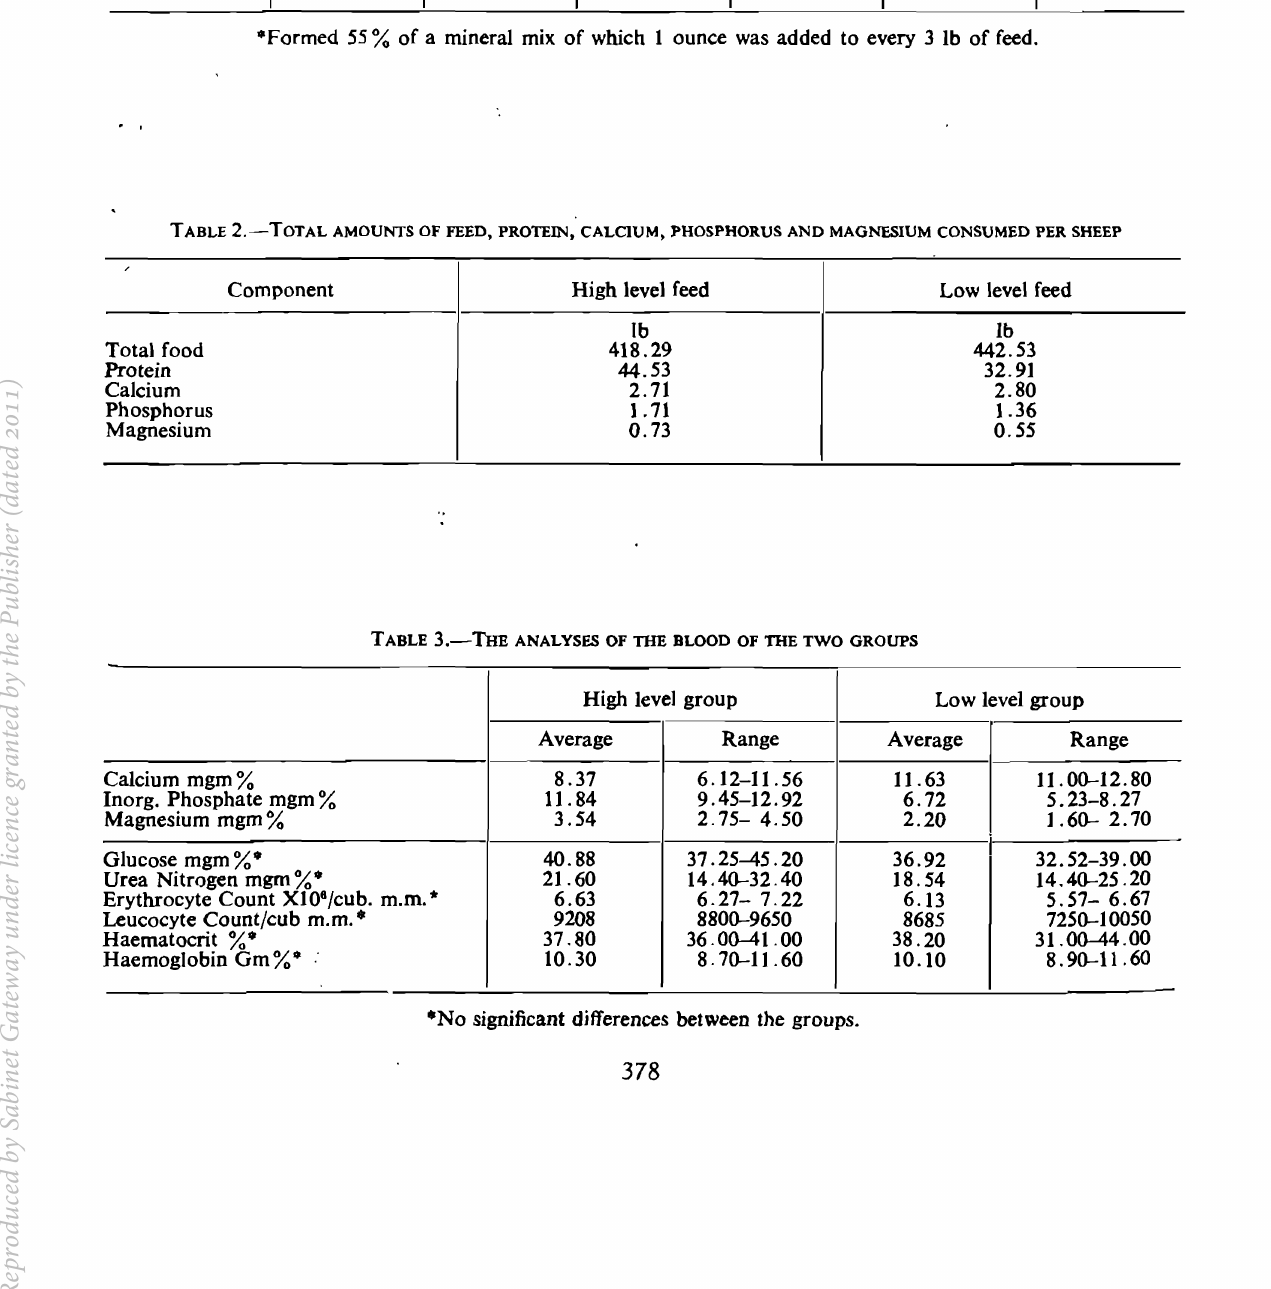
TABLE 2.- TOTAL AMOUNTS OF FEED, PROTEIN, CALCIUM, PHOSPHORUS AND MAGNESIUM CONSUMED PER SHEEP